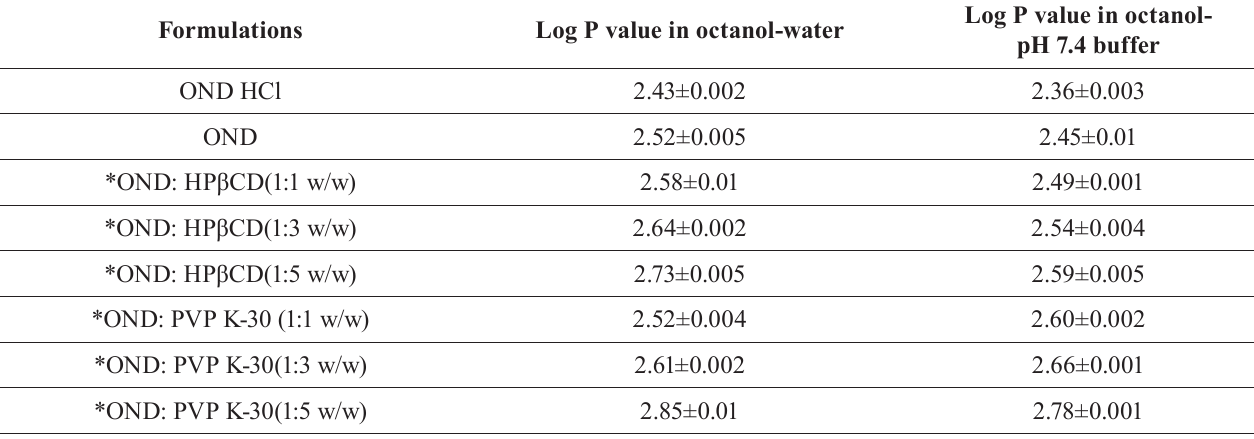
TABLE II - Study of Partition coefficient